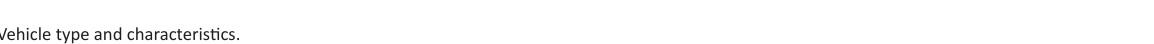
TABLE 2: Vehicle type and characteristics. Vehicles